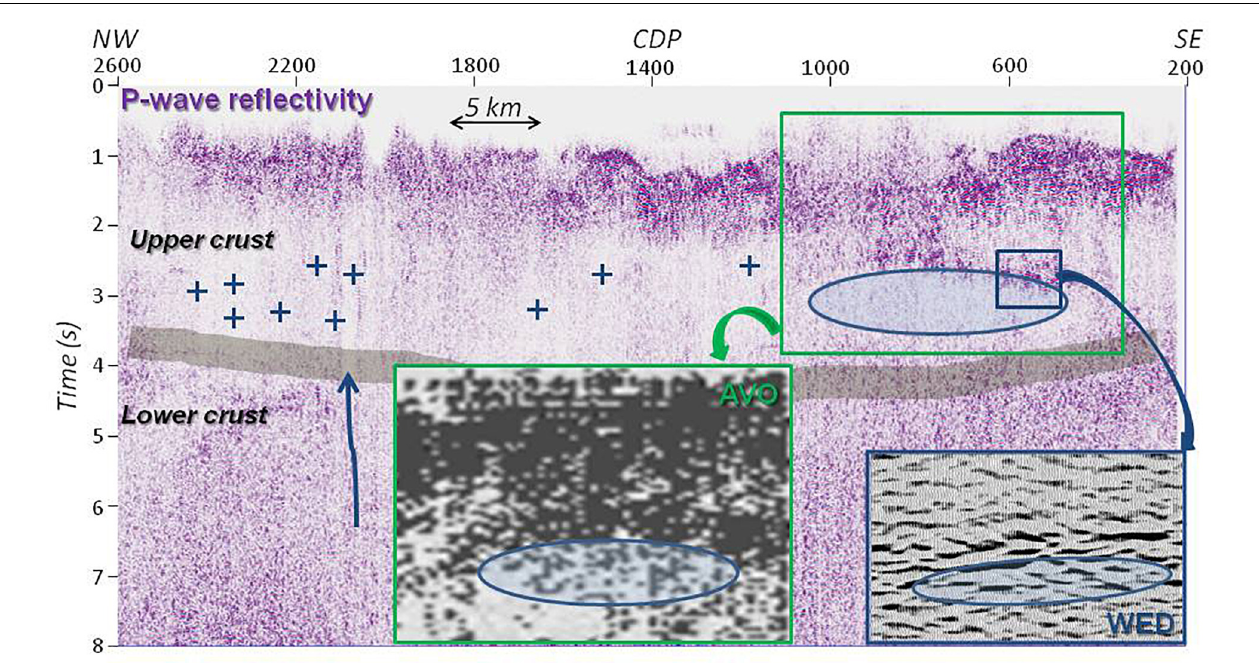
FIGURE 12 | Example of P-wave reflectivities from the Tuscan geothermal field [data from Tinivella et al. (2005)] demonstrating the advantage of the joint use of seismic methods. A combined analysis of P- and S-wave reflectivities (AVO) within the green-framed area of the P-wave reflectivity plot shows general evidence for fluid overpressure (white spots). The high P-wave amplitude contrast is well imaged in the seismic line after the application of WED [blue box; data from Giustiniani et al., 2015)]. Light-blue zones: fluids. Blue arrow: vertical channel. Blue crosses: magmatic intrusions. The gray area indicates a regional reflecting zone related to lithologic change and may correspond to the brittle-ductile transition